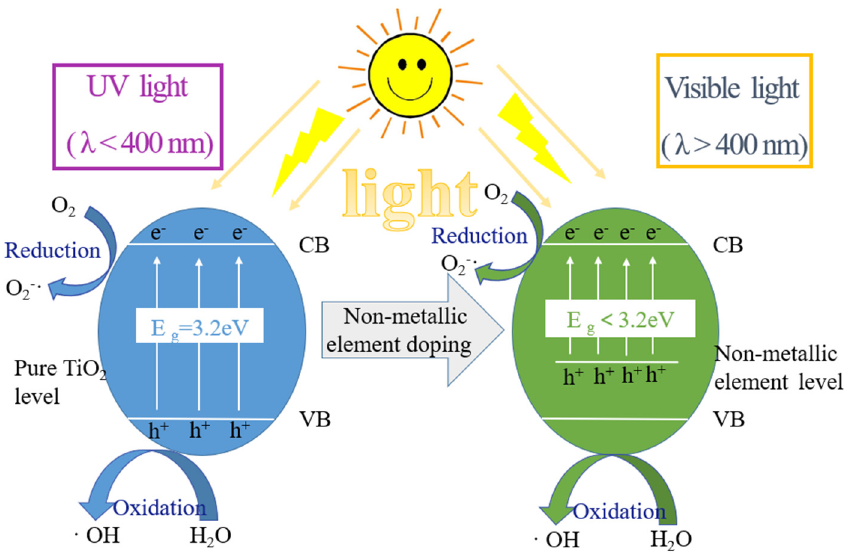
Figure 2. The mechanism of non-metallic element doping modification system.